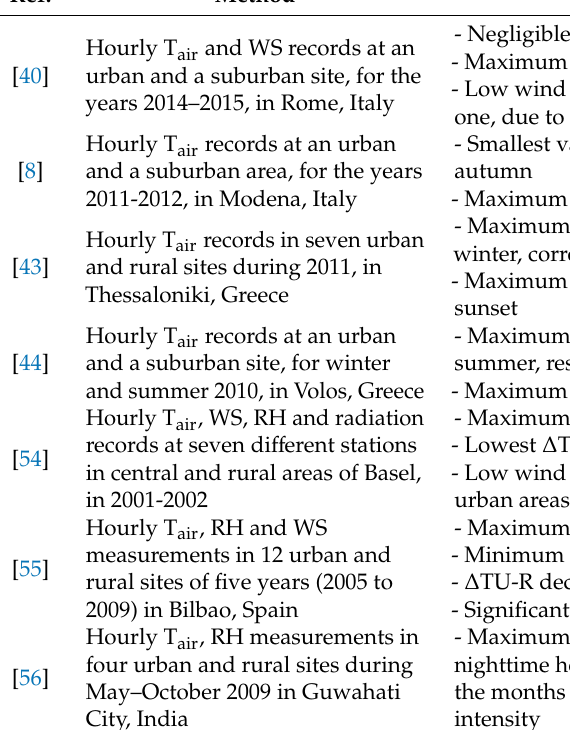
Table 1. Summary of previous studies, using experimental methods to investigate the urban